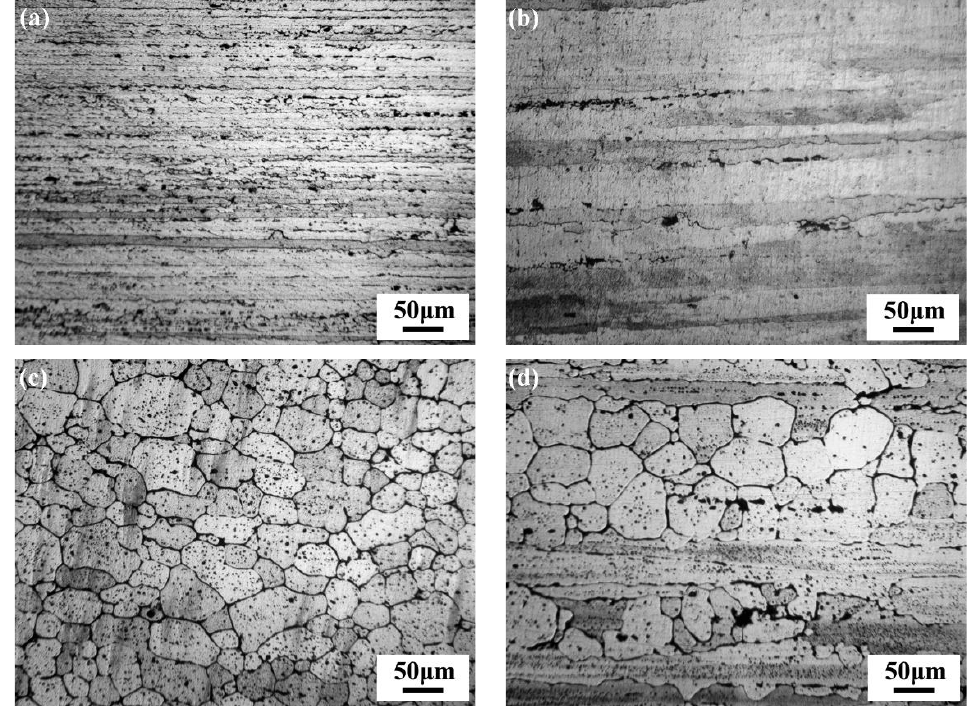
Figure 9. Microstructure of 7075 aluminium alloy after partial re-melting at 630 °C for different holding times: ( a ) 10 min at the edge; ( b ) 10 min at the centre; ( c ) 20 min at the edge; ( d ) 20 min at the centre.